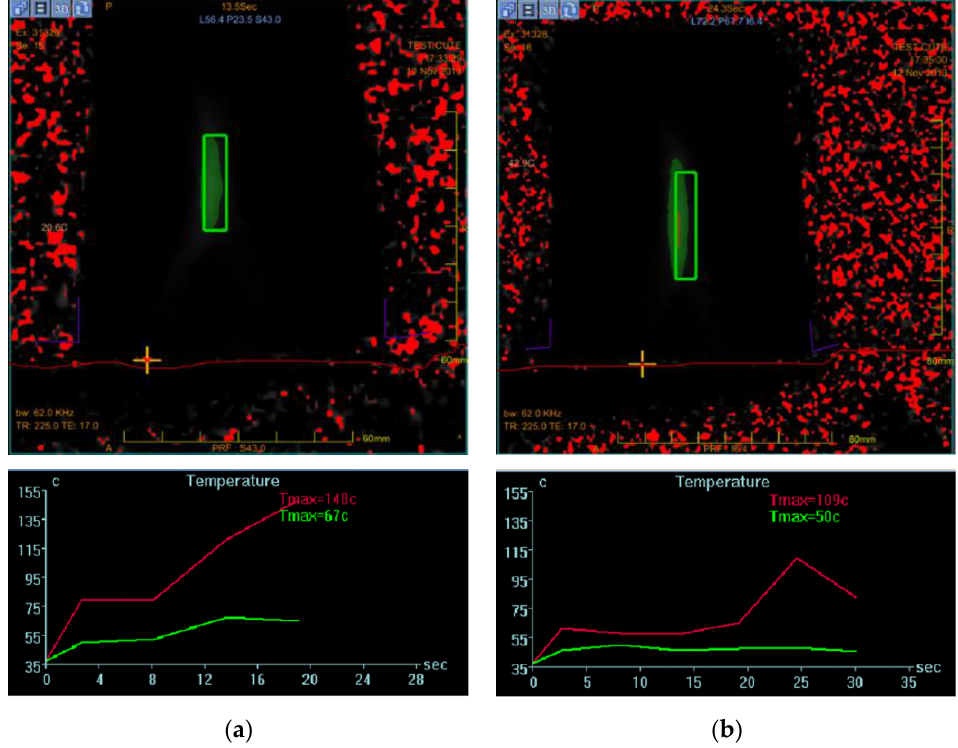
Figure 1. ( a ) Thermal map of a sonication during a treatment. The crosshair cursor, selected by the operator, represents the point of interest for temperature trend control. ( b ) Temperature plot of a single pixel (red line) and a small neighboring region around the crosshair cursor (green line).